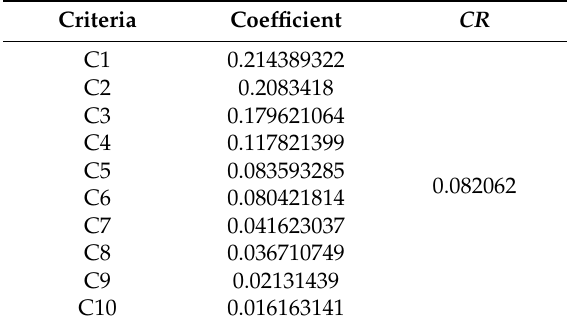
Table 8. Weight coefficient criteria and their level of consistency.